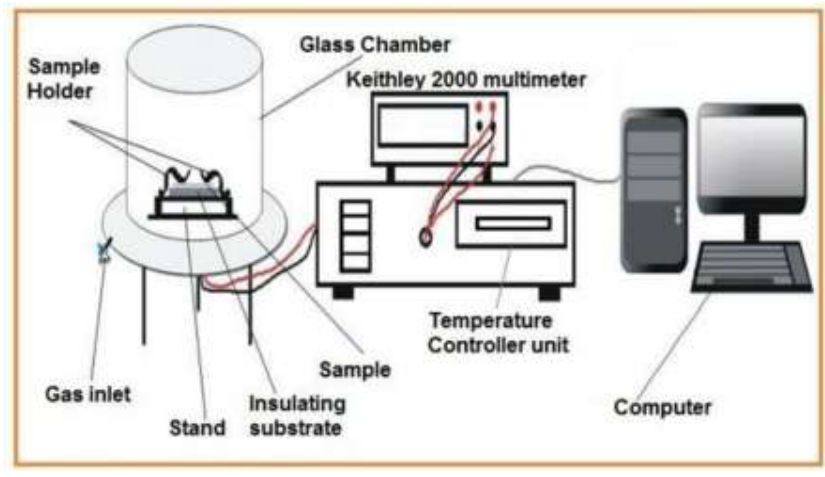
Figure 2: Experimental set-up of gas sensor